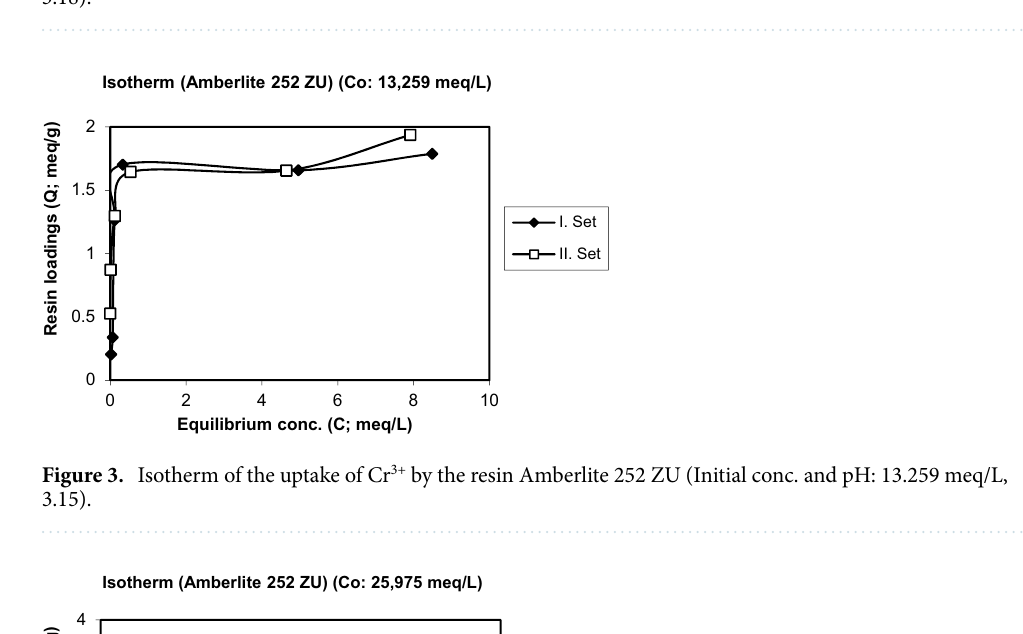
Figure 2. Isotherm of the uptake of Cr 3+ by the resin Amberlite 252 ZU (Initial conc. and pH: 5.173 meq/L, 3.18).